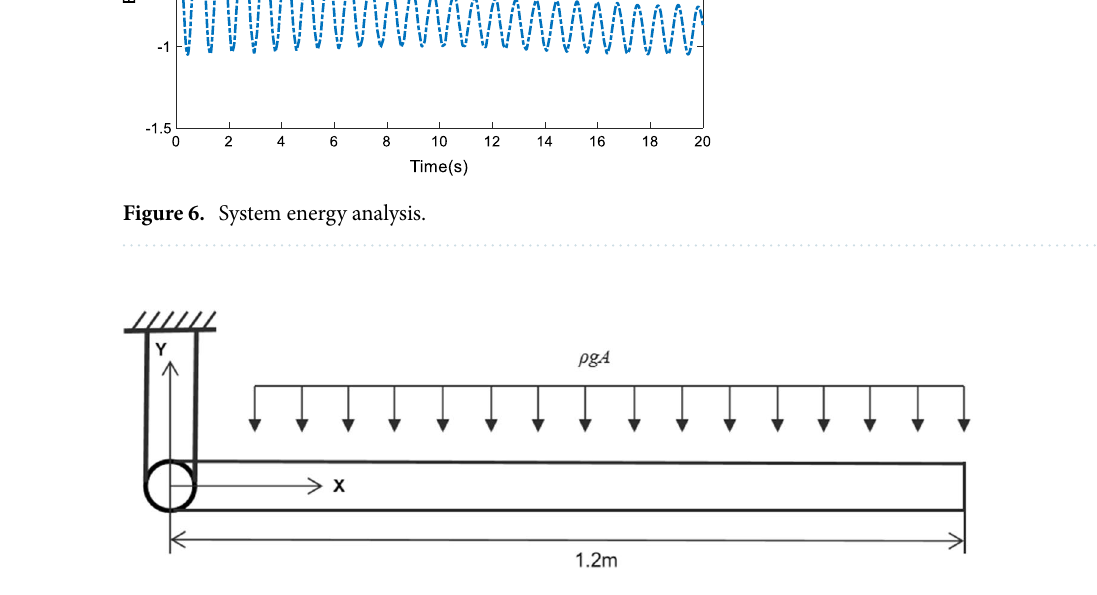
Figure 7. Free falling flexible